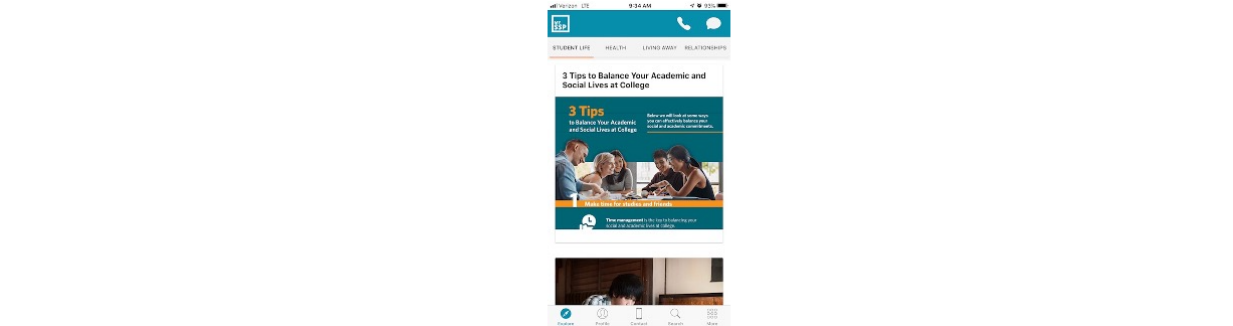
Figure 1. Student life screen of the MySSP app.